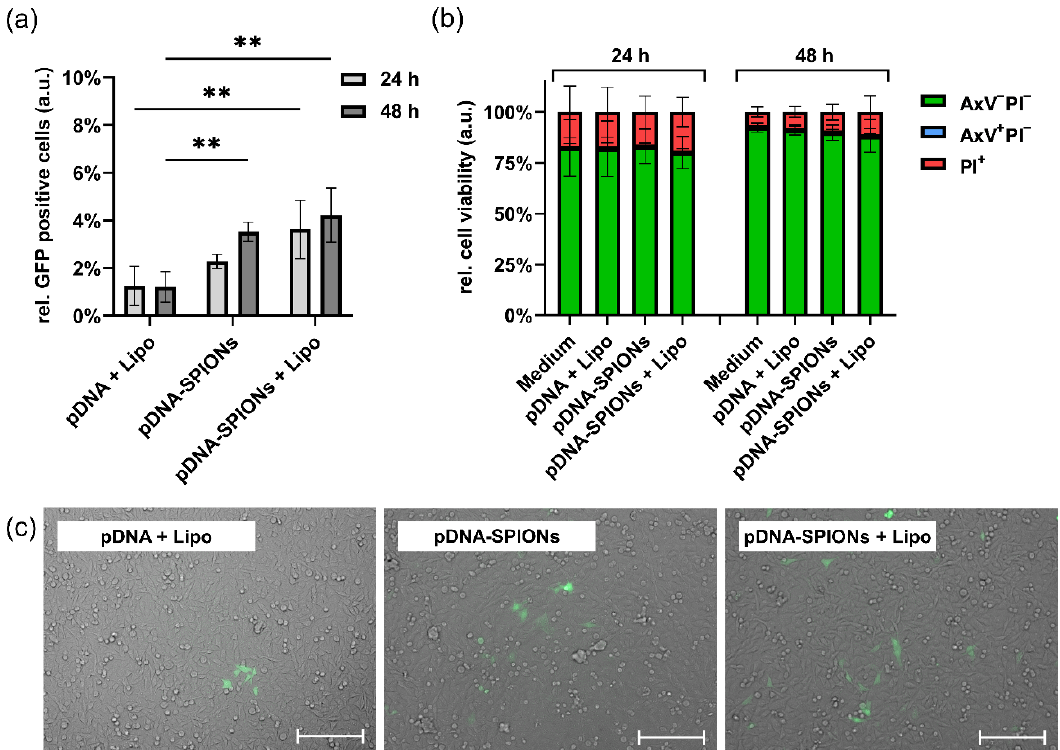
Figure 3. Transfection of 10 ng pDNA into A375-M cells using Lipo, pDNA-SPIONs and pDNA- SPIONs + Lipo. ( a ) Relative amount of GFP positive cells and ( b ) relative cell viability after incubation of the three different systems for 24 and 48 h. Statistically significant changes were calculated with two-way ANOVA (** for p < 0.01). ( c ) Exemplary microscopic images of transfected cells after 48 h of incubation. The scale bar represents 200 µ